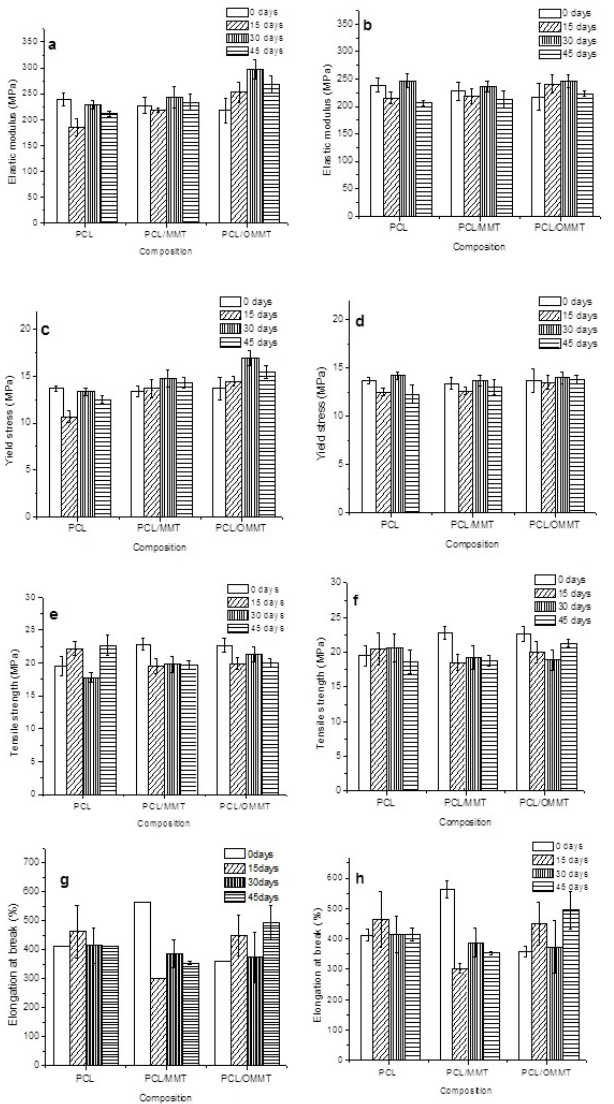
Figure 6. Mechanical properties of PCL, PCL/MMT and PCL/OMMT compounds upon addition of 3% w/w clay content. (a), (c), (e) and (g) specimens exposed to vacuum at 40oC; (b), (d), (f) and (h) specimens immersed in water at 40oC. Degradation time